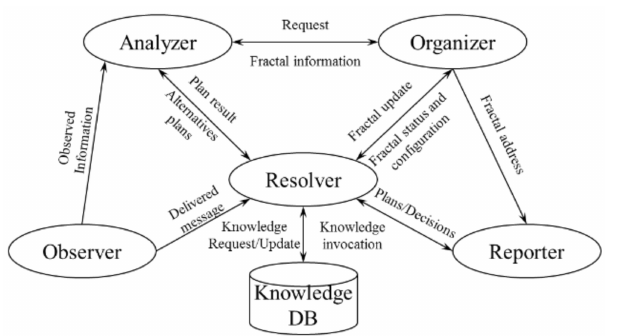
Figure 2. Five functional modules in a